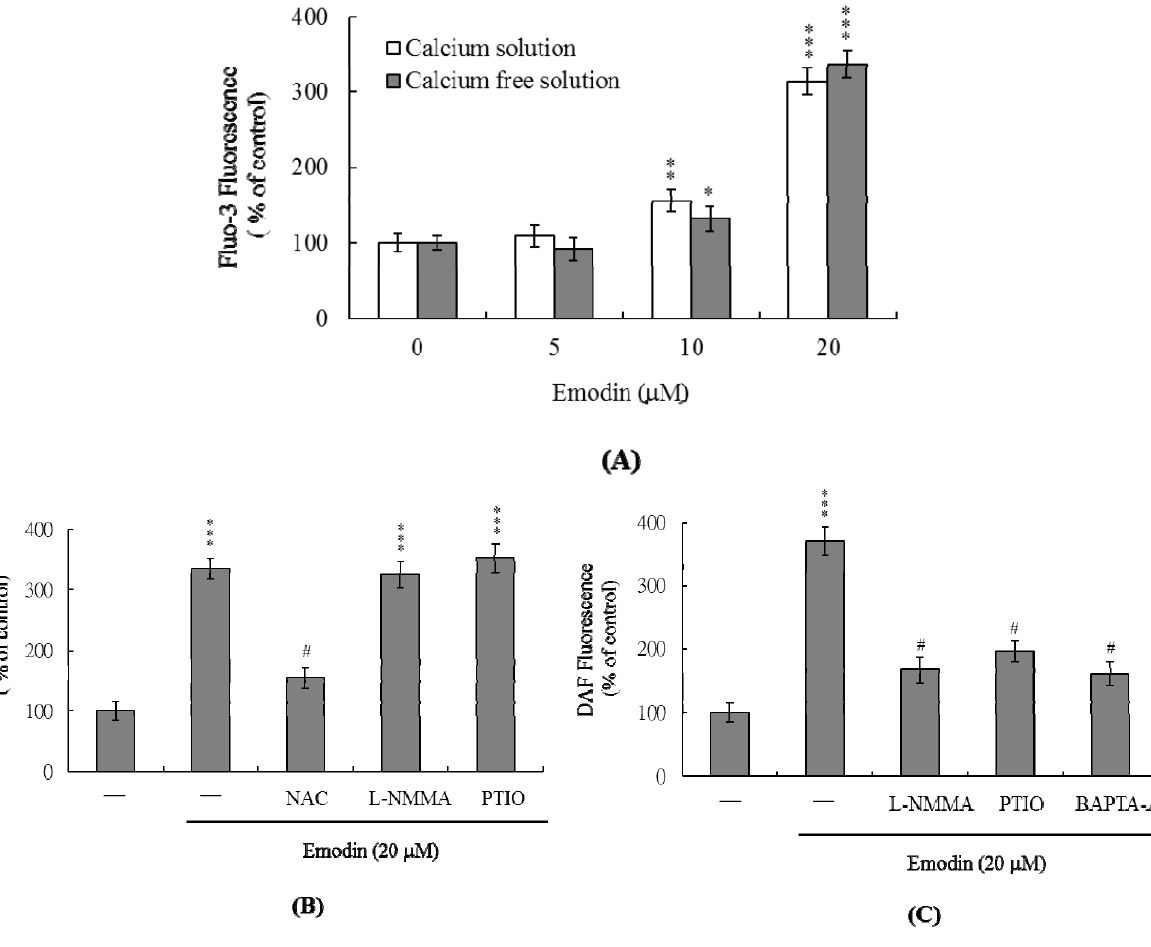
Figure 3. Emodin induces changes in the intracellular calcium and nitric oxide (NO) content of IMR-32 cells. ( A ) IMR-32 cells were incubated with 0–20 μ M emodin for 24 h. Intracellular Fluo-3 fluorescence intensity was measured in the presence/absence of extracellular Ca 2+ ; ( B ) Intracellular Ca 2+ level changes following treatment with 20 μ M emodin and effects of ROS and NO inhibitors (NAC: 300 μ M; L-NMMA: 400 μ M; PTIO: 20 μ M) were examined; ( C ) IMR-32 cells were pretreated with L-NMMA (400 μ M), PTIO (20 μ M) or BAPTA-AM (10 μ M) for 30 min, followed by incubation in the presence or absence of 20 μ M emodin. Intracellular NO generation was measured using DAF-2DA fluorescence dye. Data are presented as a percentage of the control group. * p < 0.05, ** p < 0.01 and *** p < 0.001 versus the untreated control group. # p < 0.001 versus the “emodin-treated”